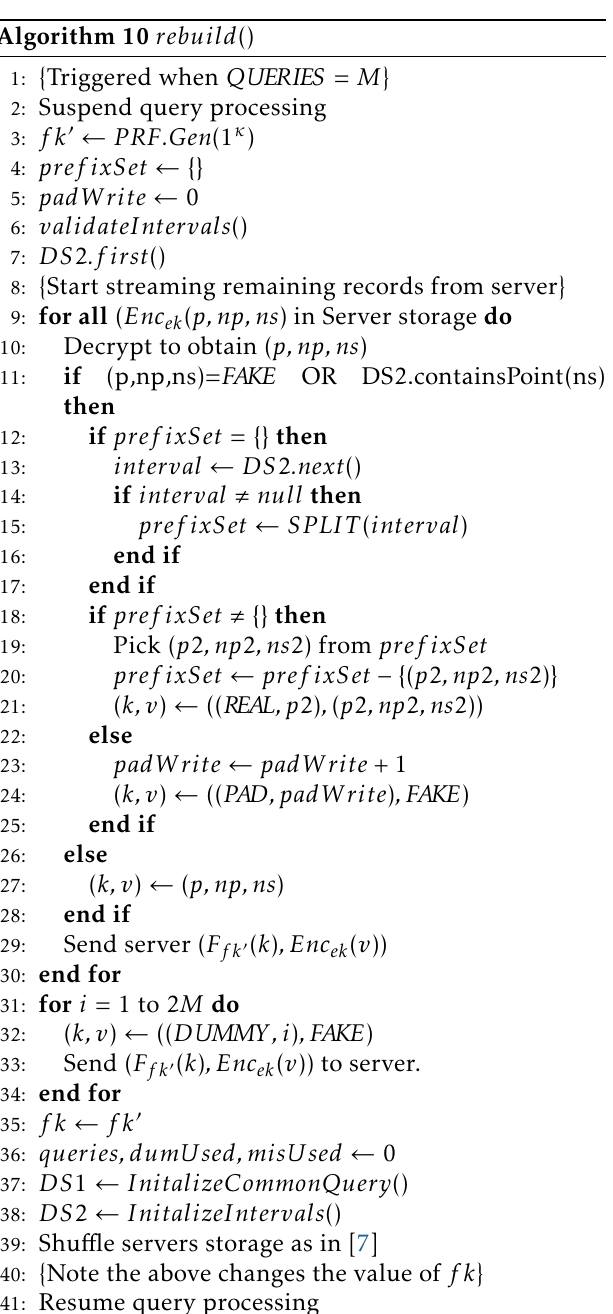
Table 2. Comparison between the Original Scheme and the Index Overhead Metric Traditional Index Overhead Server Storage Client Storage Online computation Online